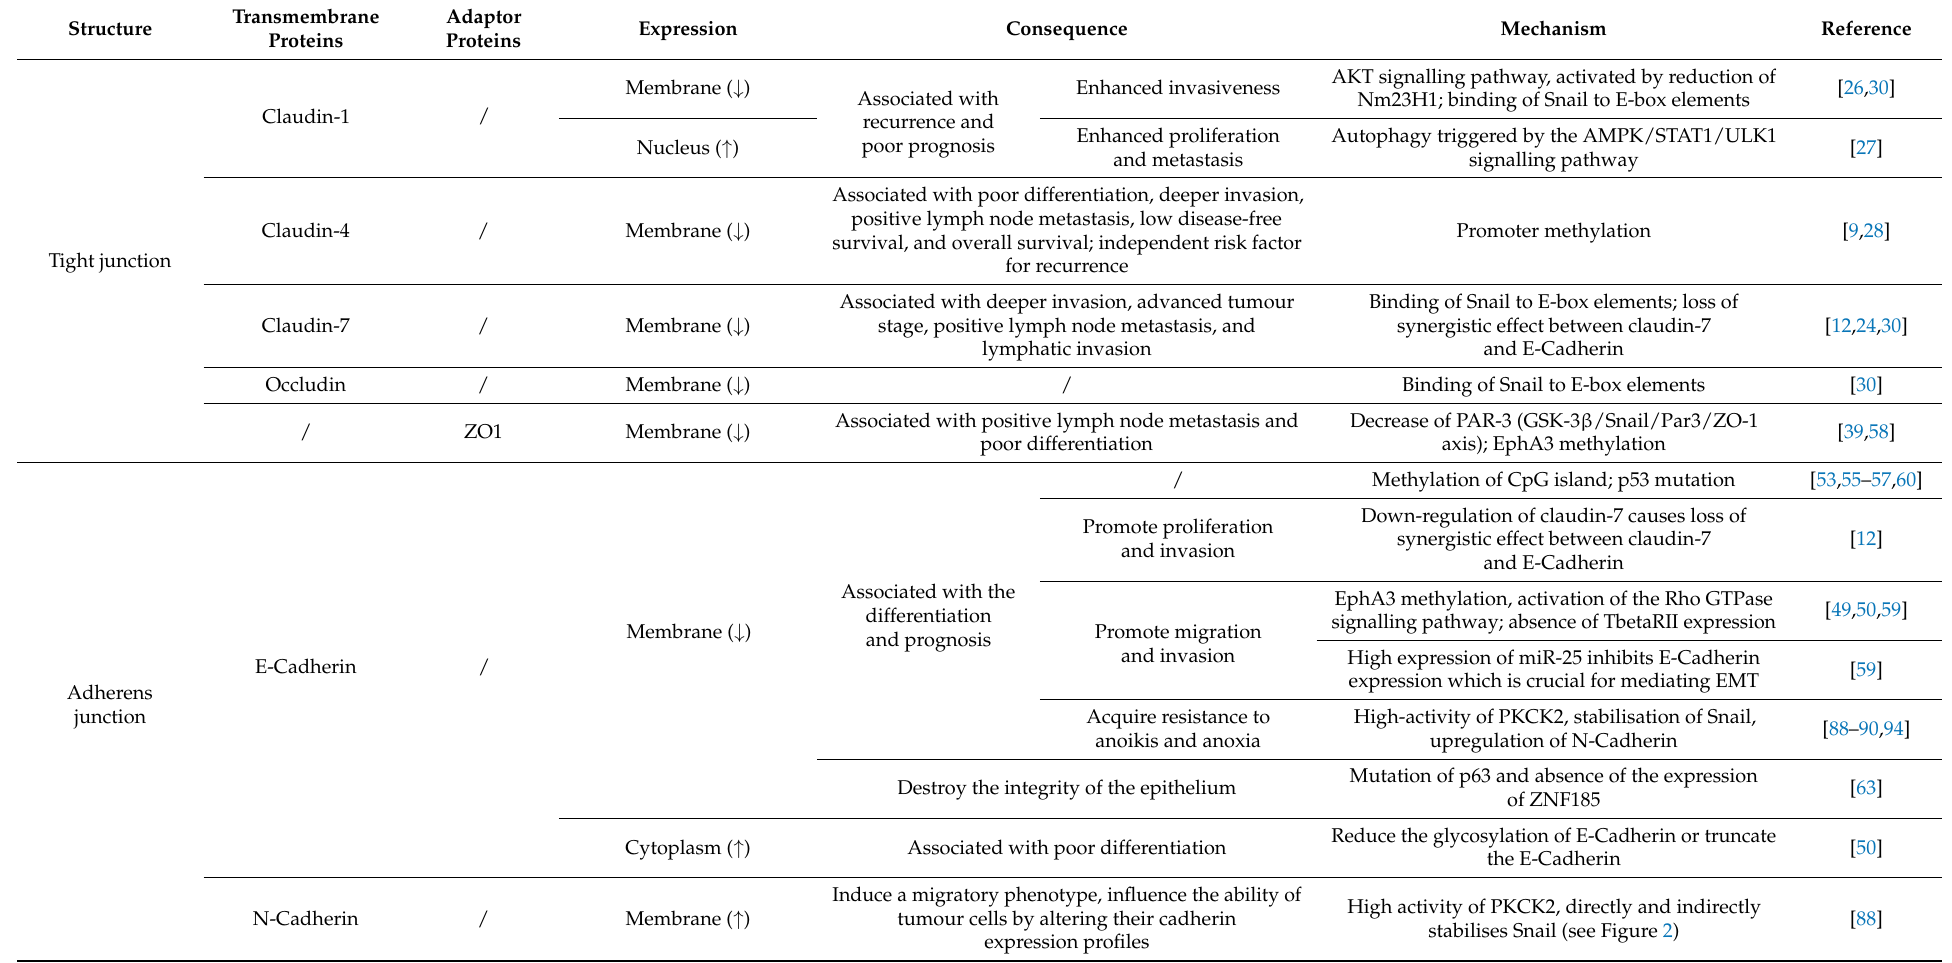
Table 1. Summary of changes and mechanisms of cell-cell junction components in